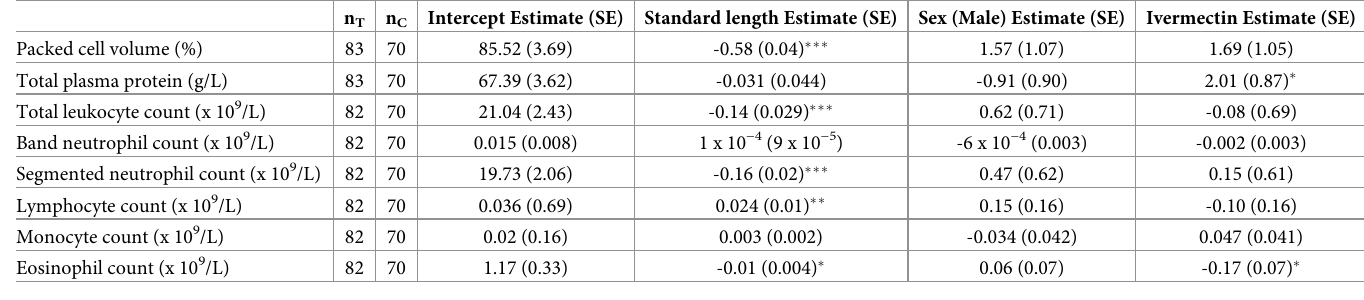
Table 1. Summary of linear mixed effects models for haematological parameters of New Zealand sea lion pups with covariates of standard length as a surrogate for age, sex and ivermectin treatment group, with individual pup identity as a random effect. Sample size for ivermectin-treated (n T ) and control (n C ) pup samples are